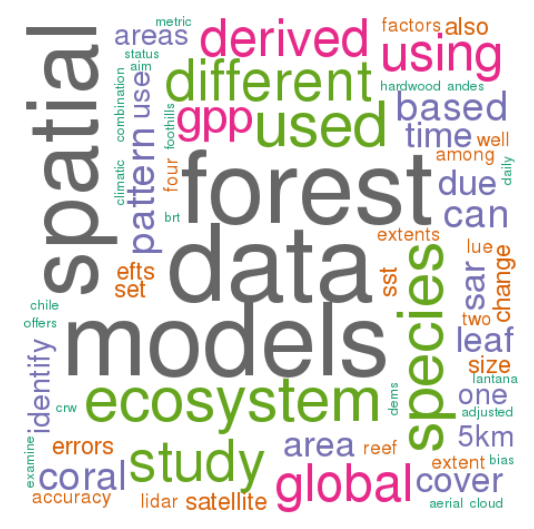
Cloud of the words contained in the abstracts of the special issue “Earth Observation for Ecosystems Monitoring in Space and Time”. The bigger the size, the higher the frequency of each word. The code and the set needed to produce the cloud are available in the Supplementary